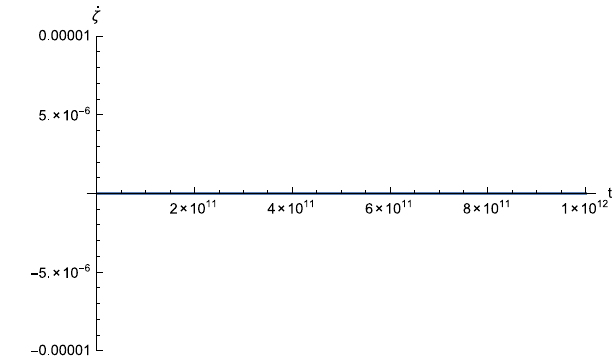
Fig. 6 Thenumericalplotof ζ intermsofthecosmictime t beforecur- vaton domination. We choose the parameters as ξ = 1, M = 10 − 4 M p , m = 10 − 6 M p . The initial conditions for δϕ are δϕ i = 10 − 4 M p , ˙ δϕ